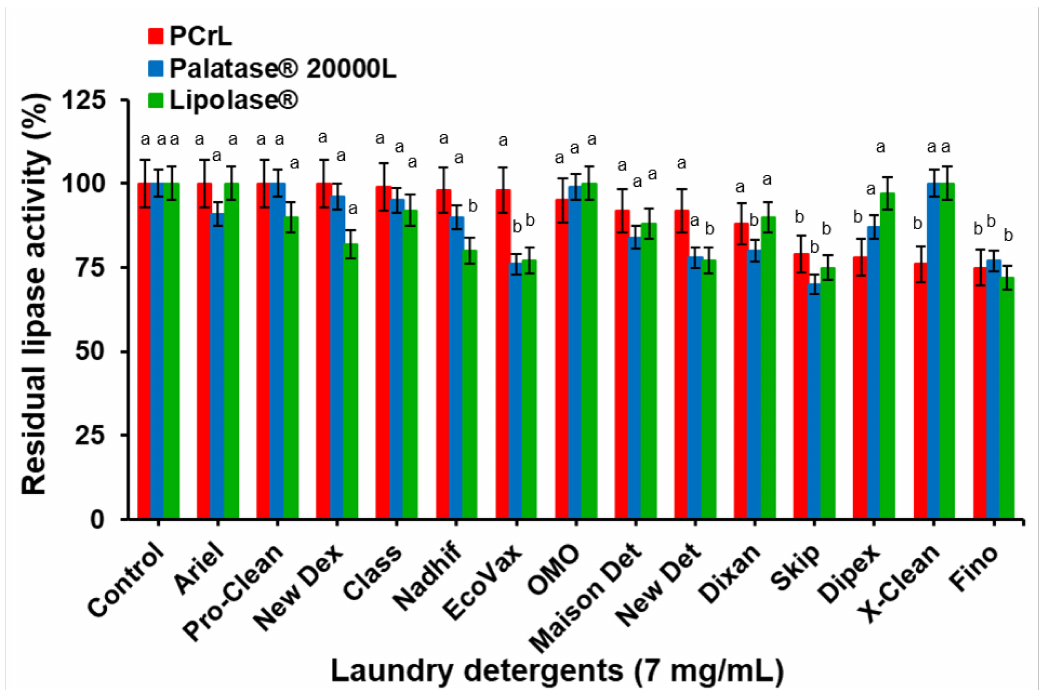
Figure 9. Stability and compatibility of the tested lipases in the presence of commercial laundry detergents. Lipases were incubated with laundry detergents (7 mg/mL) for 60 min at 37 ◦ C. The enzyme activity of the control sample, without additive and incubated under similar conditions, was taken as 100%. Each point represents the mean of three independent experiments. Vertical bars indicate the standard error of the mean ( n = 3). a–b Means in indicator enzymes with different lowercase letters differed significantly ( p <